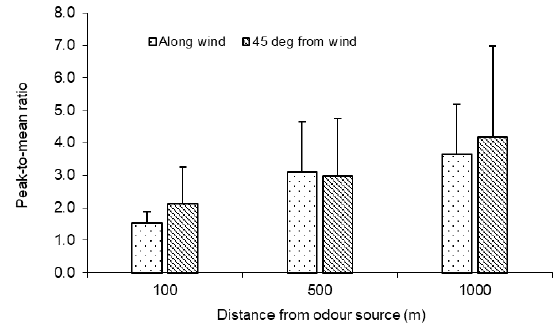
Figure 9. Comparison of measured PMR_OIs (30 minute averaging time) between 0 ° (along the wind direction) and 45 ° from wind direction at 100, 500, and 1000 m from the odour source.